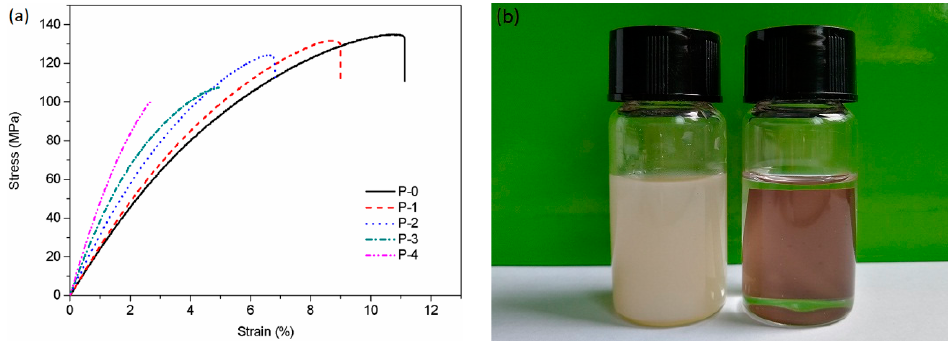
Figure 7. ( a ) The stress-strain curves of the CPEN/F-BaTiO 3 composite films; and ( b ) digital figures of composite films with same filler loadings in NMP: uncross-linked (left); and cross-linked (right).